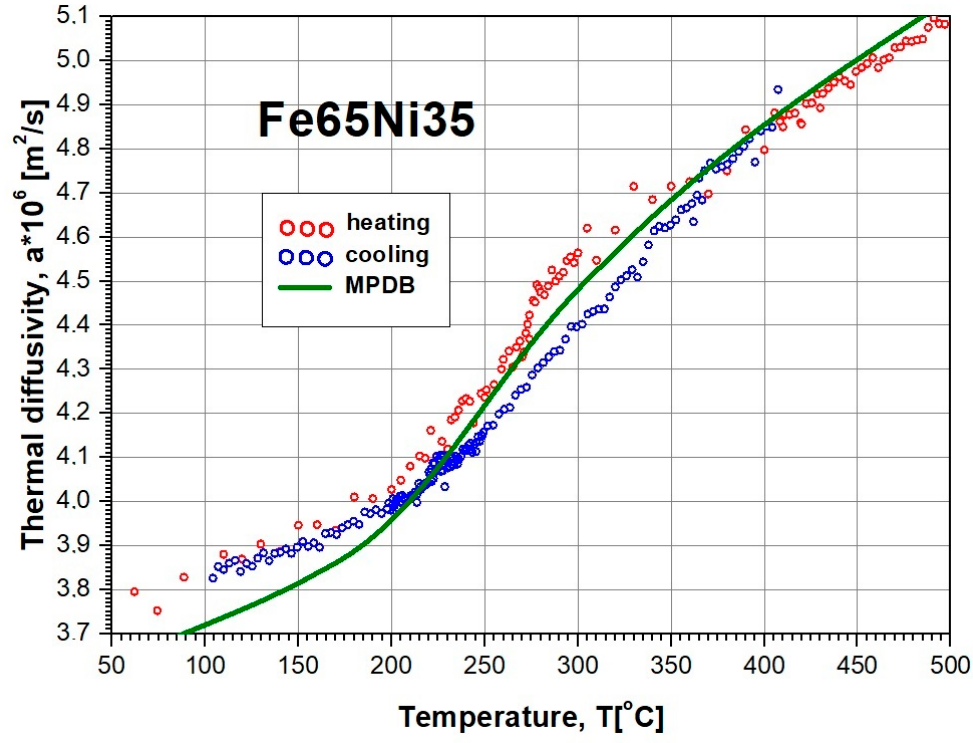
Figure 6. Results of own investigation of thermal di ff usivity a ( T i ) for Fe65Ni35 alloy during sample heating and cooling, and results obtained indirectly for Fe64Ni36 alloy using dependence of a = λ / ( ρ c P ) and data from MPDB database [45].